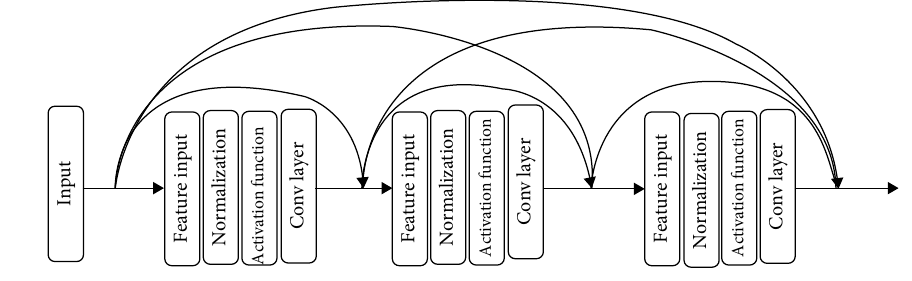
Figure 4: DenseBlock module structure.